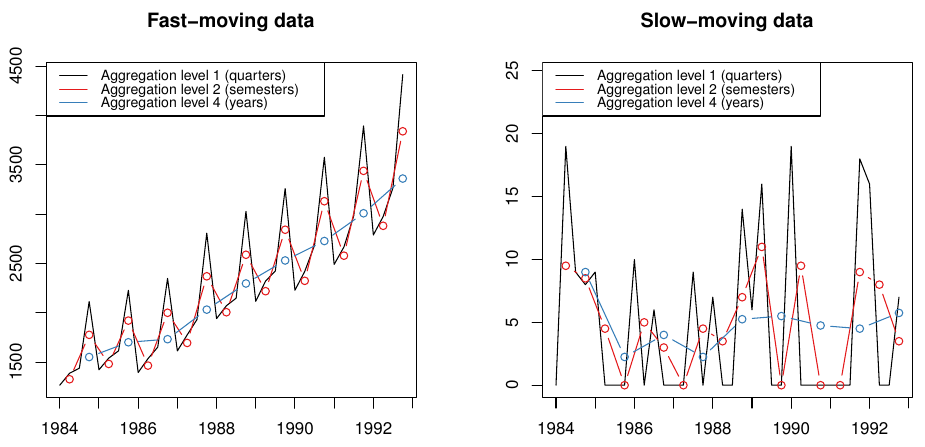
Figure 1. Visual examples where multiple new temporally aggregated time series are created based on the original data. The quarterly data (black line) are temporally aggregated to semesterly (red line) and yearly (blue line) data. For fast-moving data, the aggregation uncovers the trend of the series while for slow-moving data it filters out